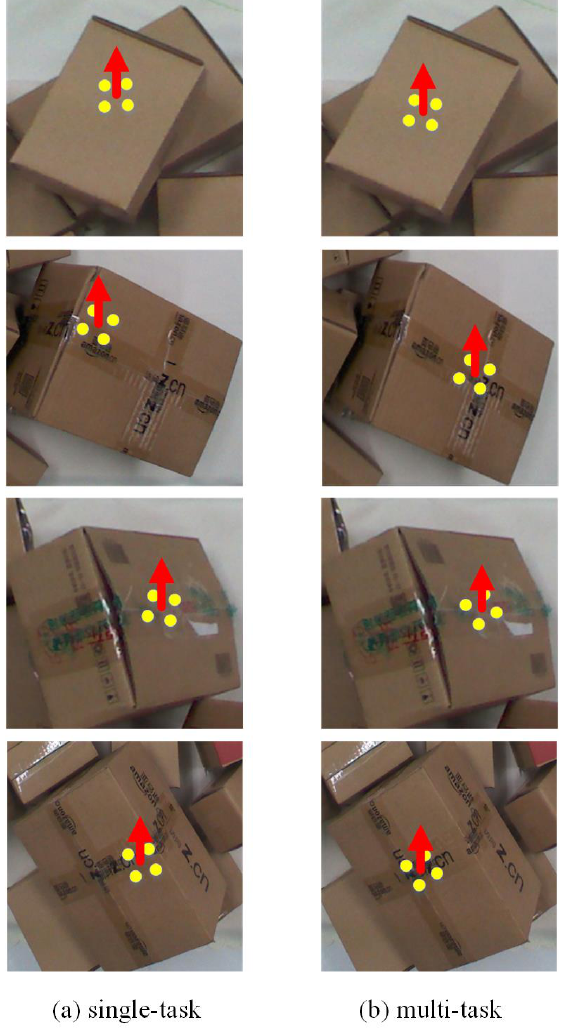
Figure 12. Comparison of the sorting locations of the single-task and multi-task